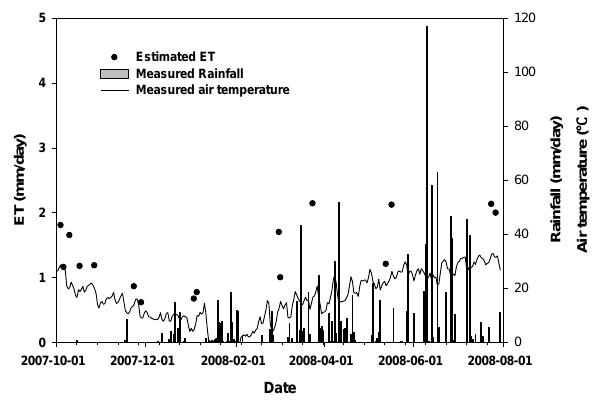
Fig. 6. Seasonal variation of estimated ET for Nanchang experimental station during the study period.